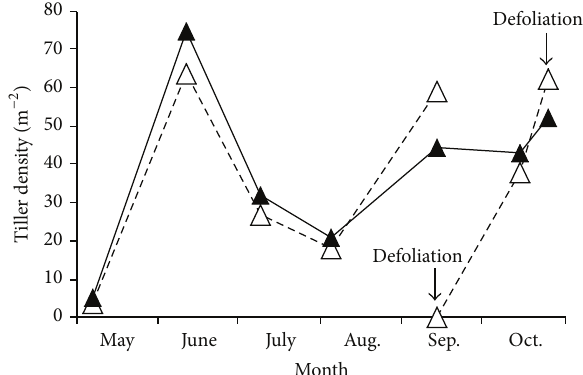
Figure 1: Changes in tiller density of Napiergrass after a single cutting ( 󳵳 ) and after two cuttings ( △